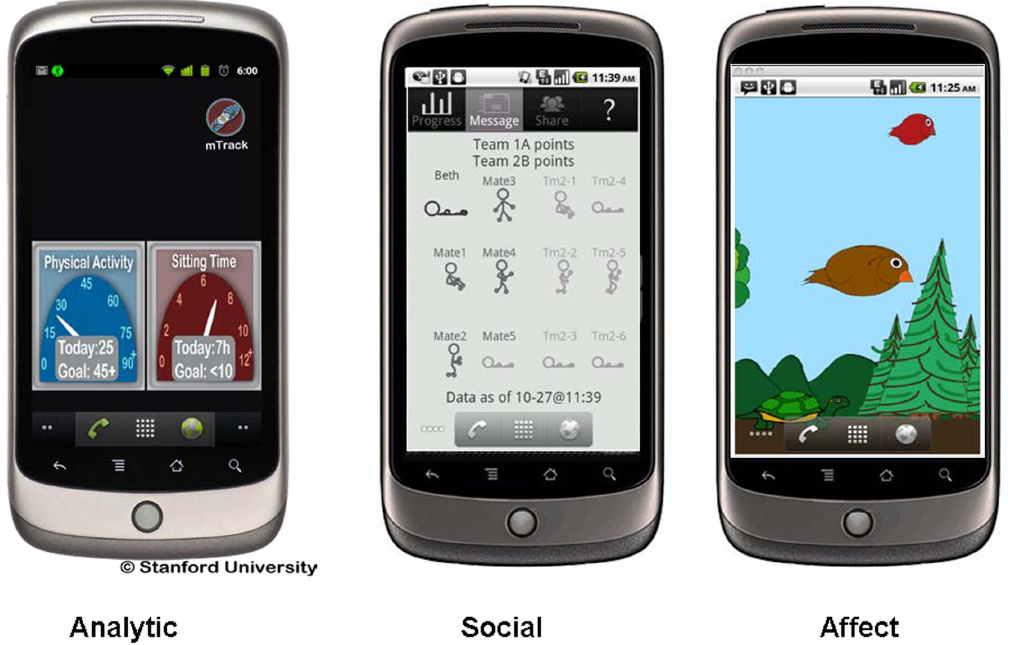
Figure 1. Live wallpaper graphics for the Analytic, Social, and Affect applications. doi:10.1371/journal.pone.0062613.g001 PLOS ONE |